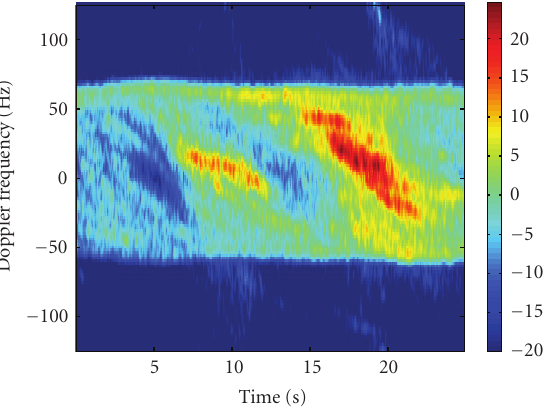
Figure 6: Doppler power (dB) spectrum measured at the top array on Kent